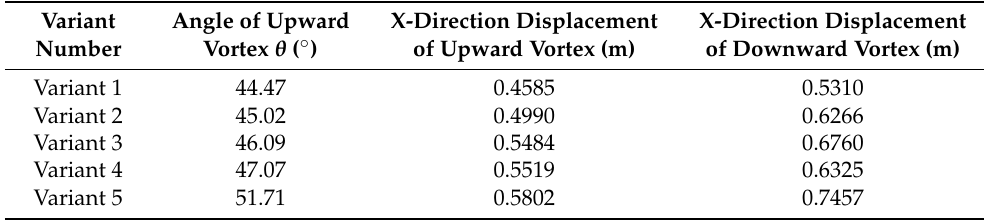
Table 3. Comparison of angle and the x-direction displacement of vortices.